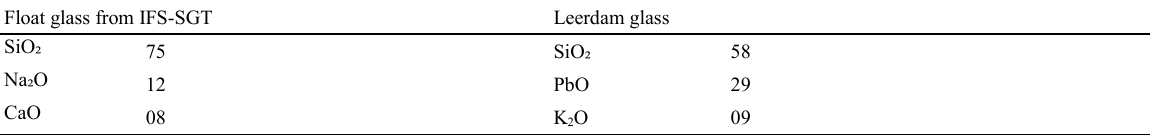
Table 3: Main chemical composition in wt% of used soda-lime and lead-crystal glass (XRF